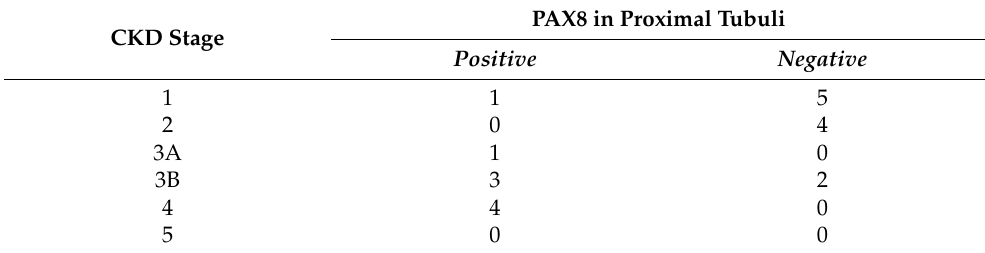
Table 2. PAX8 expression related to CKD stage in 20 patients clinically presented with nephrotic syndrome. PAX8 in Proximal CKD Stage